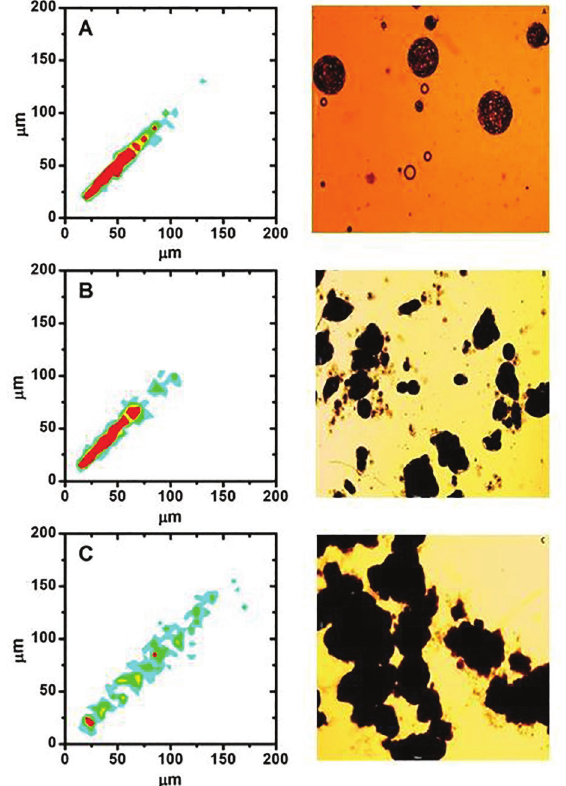
FIGURE 1 - Map of the distributions size and image of microcapsules coacervates with Attala phalerata Mart. oil under coacervation conditions: (A) 10 g core, 60 °C temperature, homogenization speed 18000 rpm; (B) 10 g core, 60 °C temperature, homogenization speed 12000 rpm; (C) 10 g core, 40 °C temperature, homogenization speed 18000 rpm increased on 40x in Optical Microscopy.